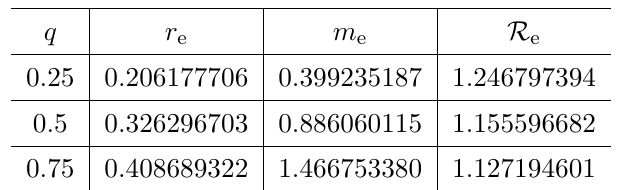
Table 1 . The numerical values of the horizon radius r e , mass parameter m e , and isoperimetric ratio R e with different electric charge parameter q in the extremal black hole case ( l = 1